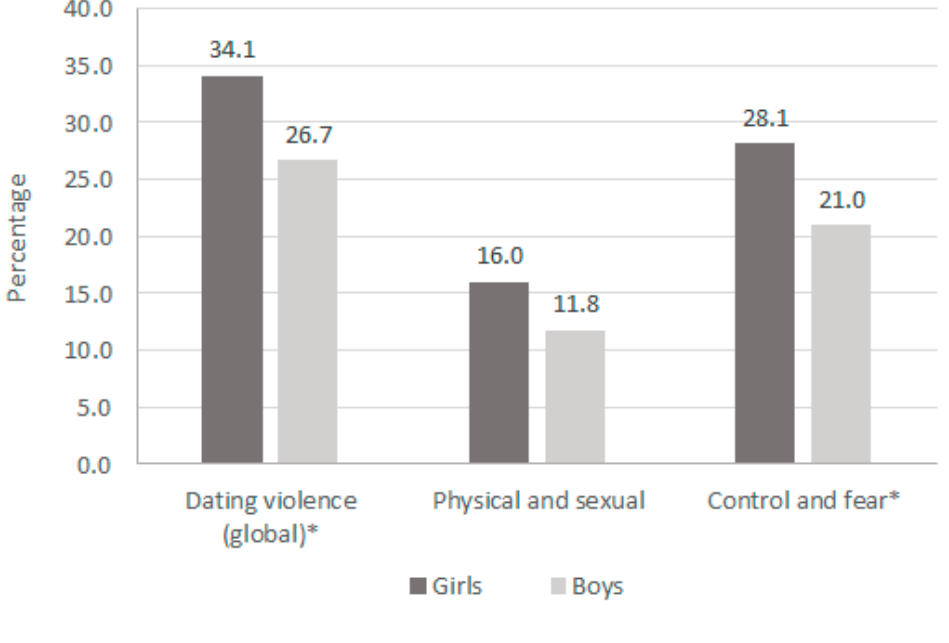
Figure 1. Dating Violence Prevalence by Type and Sex Among Adolescents Ages 13–16 From Alicante, Spain ( n = 255), Rome, Italy ( n = 285), Iasi, Romania ( n = 343), Matosinhos, Portugal ( n = 259), Poznan, Poland ( n = 190) and Cardiff, UK ( n = 204), 2018–2019.